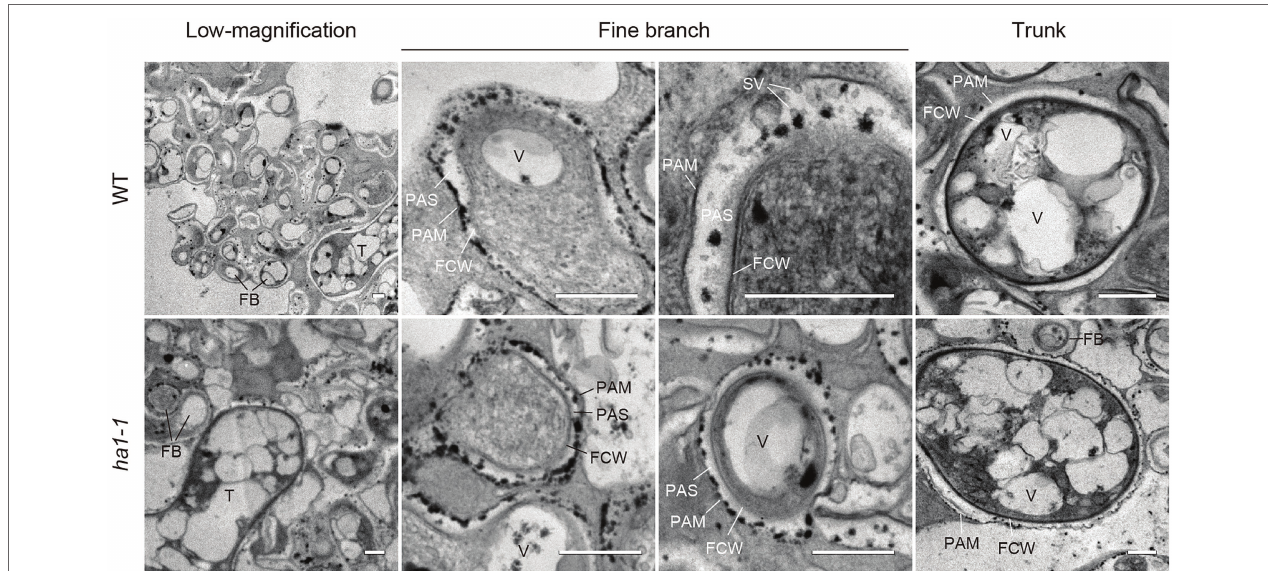
FIGURE 6 | Electron microscopic enzyme cytochemistry of acid phosphatase (ACP) activity in arbuscule-containing cortical cells. Representative transmission electron micrographs showing ACP activity in arbuscule-containing cortical cells of wild-type and ha1-1 roots colonized by R. irregularis . Fine branches and trunk hyphae of an arbuscule colonized in a cortical cell are shown. ACP activity was detected as black precipitates of the reaction product (cerium phosphate) by incubating mycorrhizal roots in acetate buffer (pH 4.6) containing β -glycerophosphate and cerium chloride. FB, fine branch; FCW, fungal cell wall; PAM, periarbuscular membrane; PAS, periarbuscular space; SV, small vesicle; T, trunk hypha; and V, vacuole. Scale bars = 500 nm.